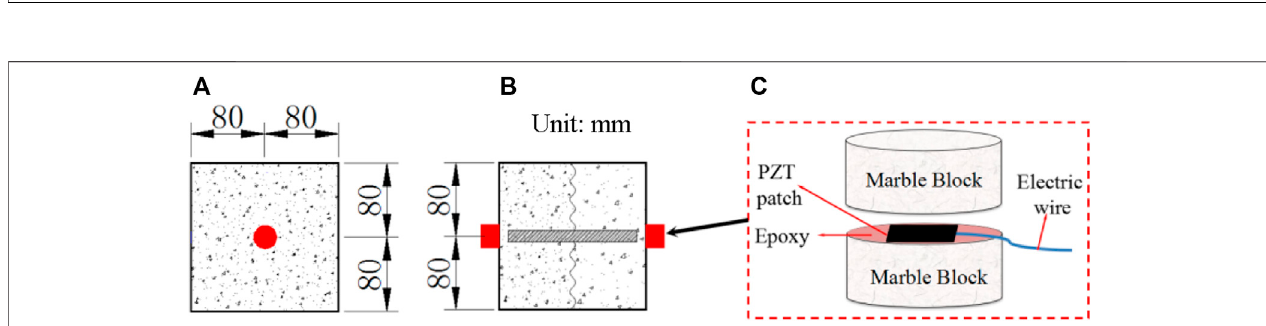
FIGURE4| Thepositionand structure ofPZTaggregates. (A) Thetopviewofthespecimen; (B) Thefrontviewofthespecimen; (C) Thepro fi leofPZTaggregates. (units mm).